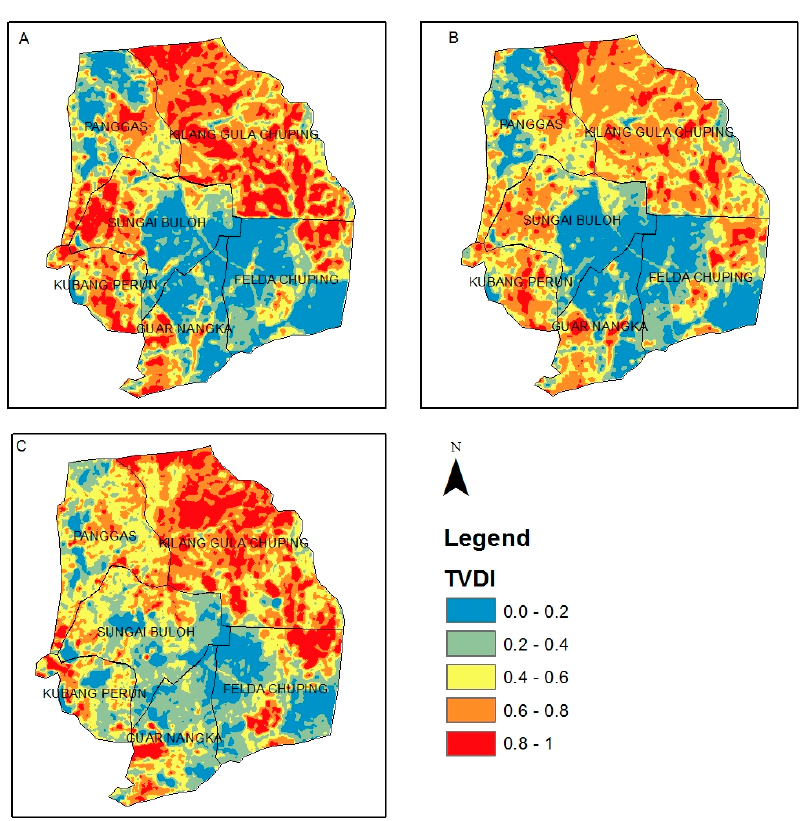
Figure 7. TVDI Map of Chuping for 2015 ( A ), 2016( B ) and 2017 ( C )